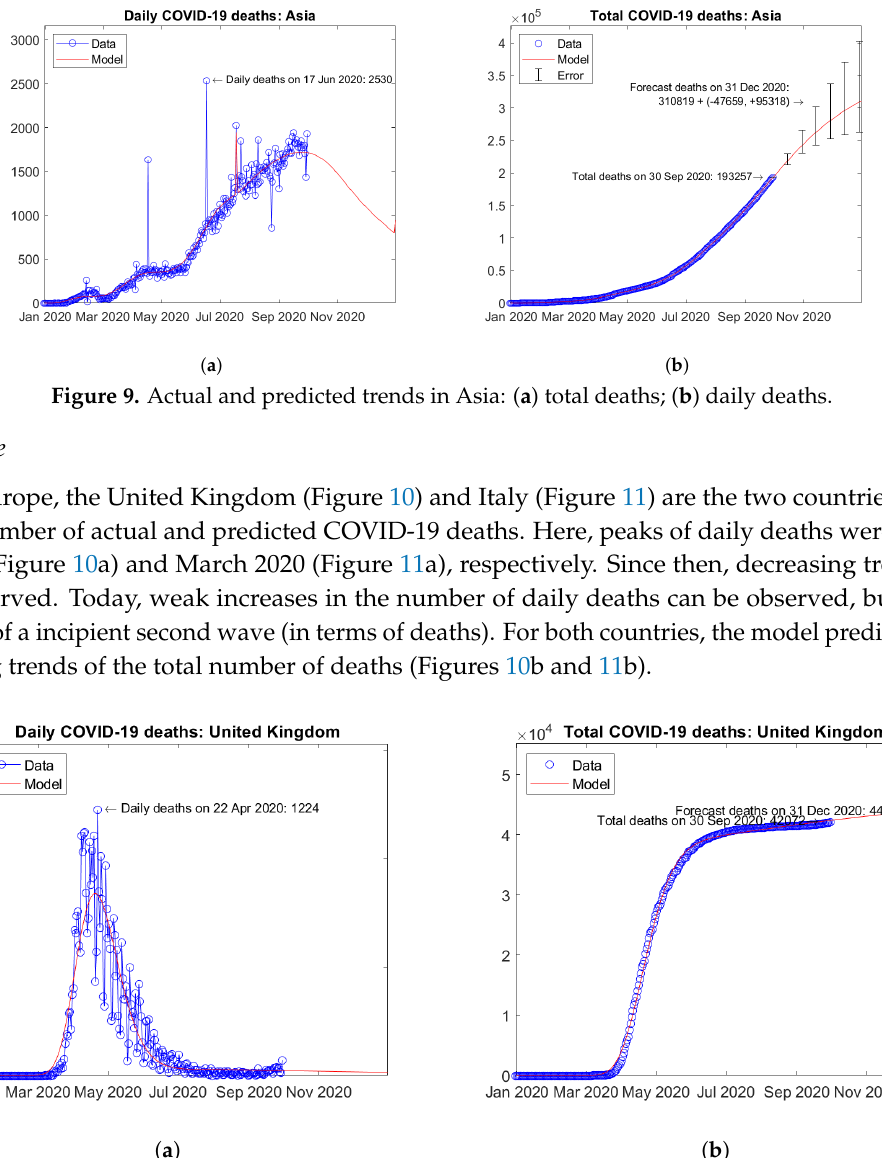
Figure 10. Actual and predicted trends in the United Kingdom: ( a ) daily deaths, ( b ) total